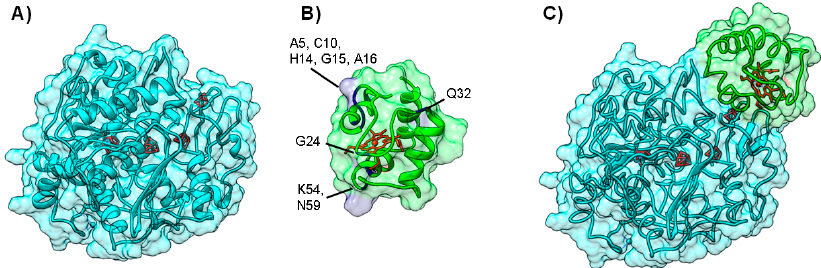
Figure 6. Electron transfer complex between Hydrogenase and cytochrome c 553 from D. desulfuricans . Panels ( A ) and ( B ) depict the backbone structure of Hydrogenase and cytochrome c 553 , respectively. Metal cofactors ([4Fe-4S] clusters and binuclear iron H cluster for Hydrogenase and c -type heme for cytochrome c 553 ) are represented in red. Grey colored residues in cytochrome c 553 are the most affected in a 1 H- 15 N HSQC NMR titration, and are clearly marked on the picture Panel ( C ) Top model structure for the electron transfer complex obtained combining NMR and soft-docking (PDB ID 1E08) [40]. Hydrogenase surface is colored cyan, while cytochrome c 553 surface is colored green. Figure prepared using UCSF Chimera [69].